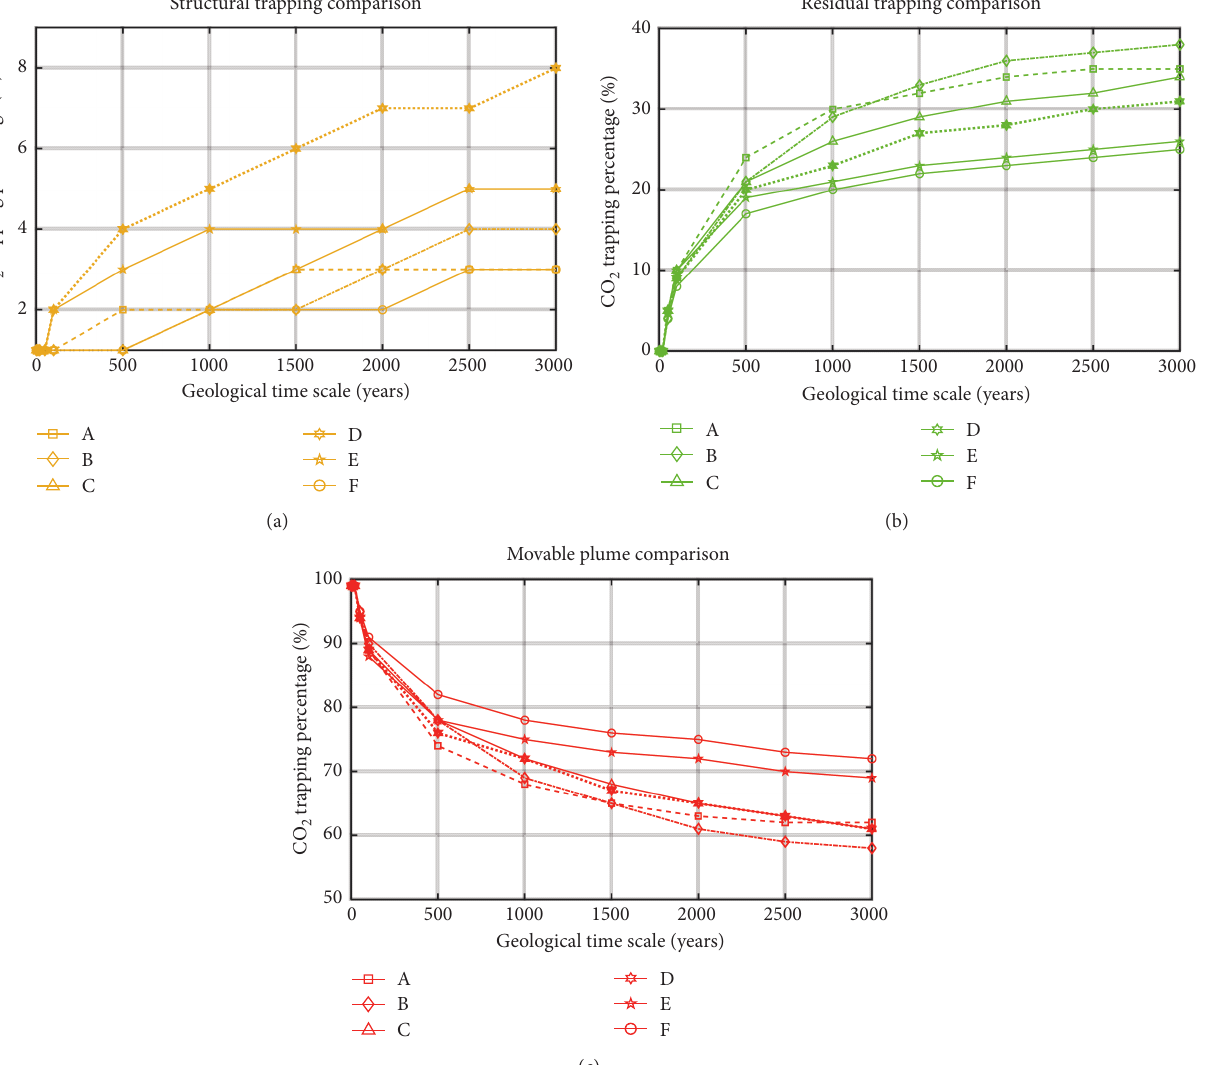
2 is injected at points A, B, C, D, E, and F of the synthetic